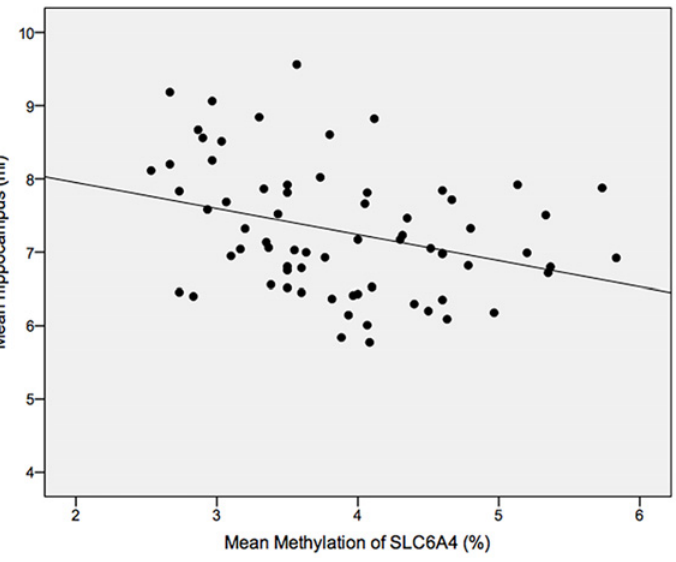
Fig 2. Scatterplot showing the association between hippocampal volumes and methylation of SLC6A4 . There was a negative correlation between both variables indicating that smaller hippocampal volumes were associated with higher levels of